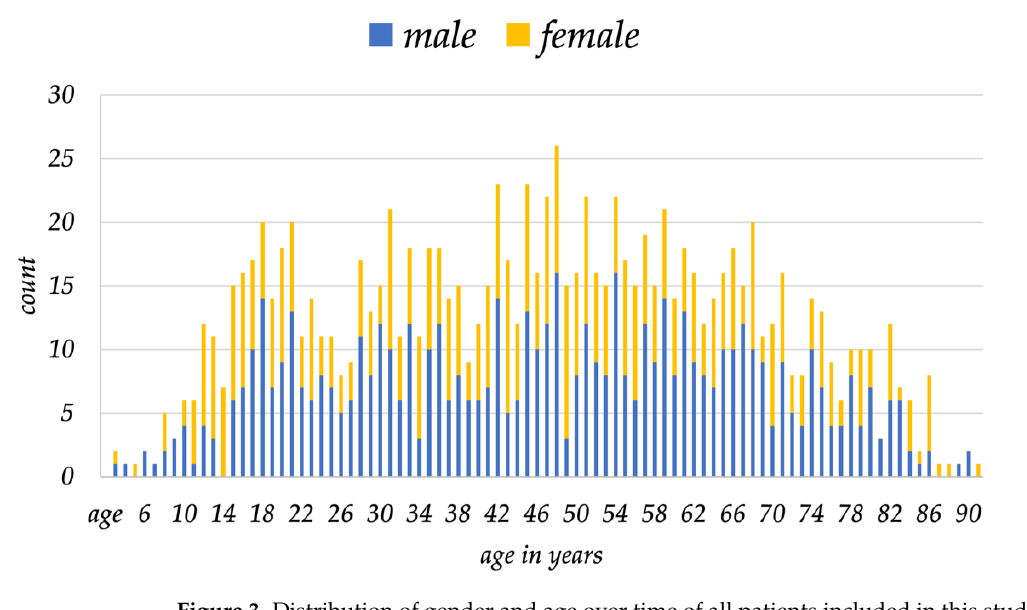
Figure 3. Distribution of gender and age over time of all patients included in this study is shown.